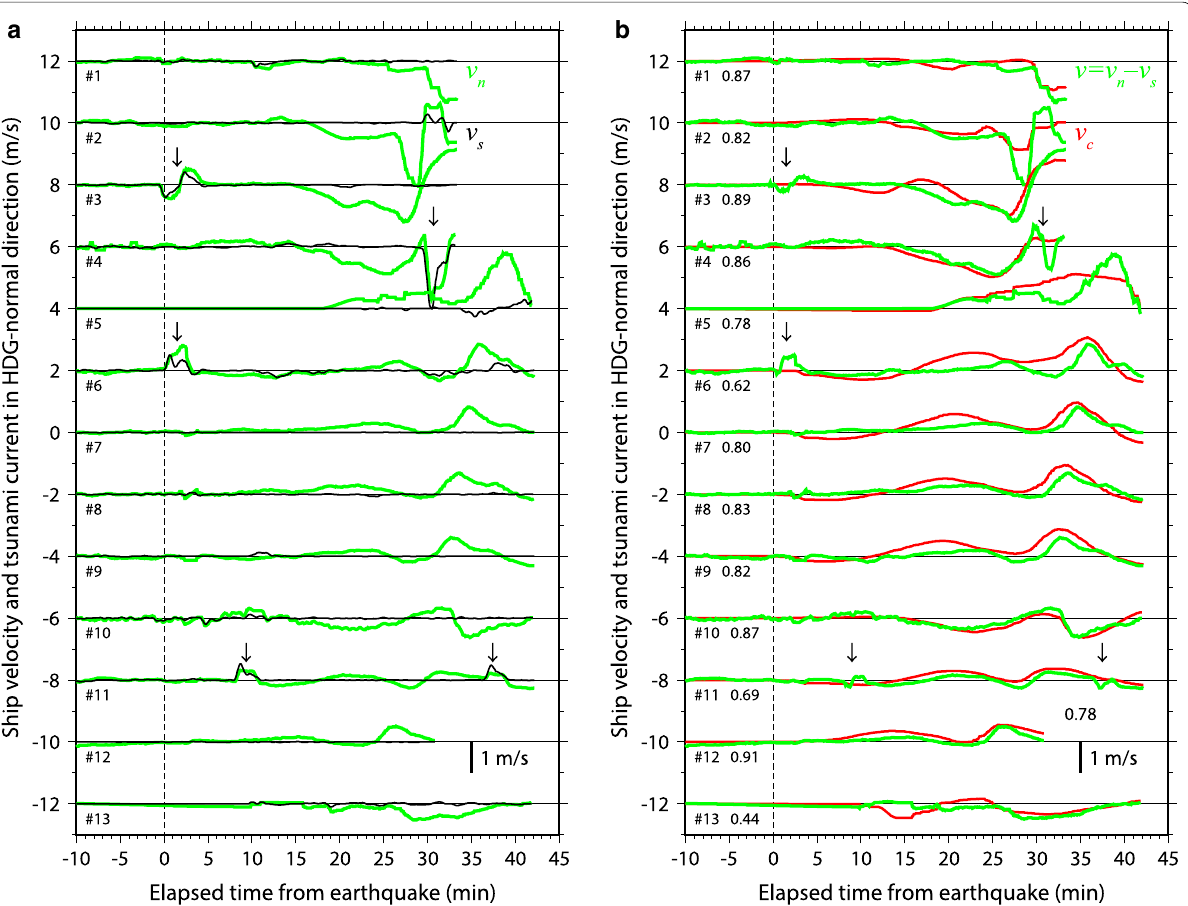
Fig. 6 Ship velocity and tsunami current in the HDG-normal direction. In a , green and black lines indicate the HDG-normal velocity shown in Fig. 3 ( v n ) and the apparent sway velocity due to ship yawing in Fig. 5 ( v s ), respectively. In b , green and red lines indicate the corrected HDG-normal velocity ( v v n v s ) and the simulated tsunami current ( v c ) shown in Fig. 3b, respectively. Arrows indicate periods where v s is relatively large in a and = − is effectively corrected in b . Correlation coefficients between v and v c are attached in the same way as in Fig.